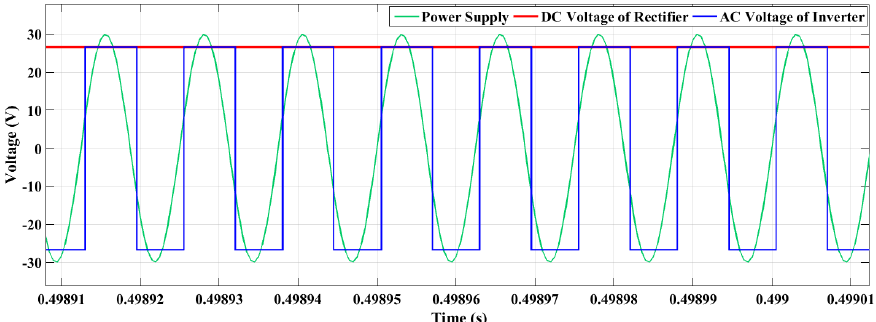
Figure 2. Simulation results of power supply, transmitter rectifier, and GaN inverter.